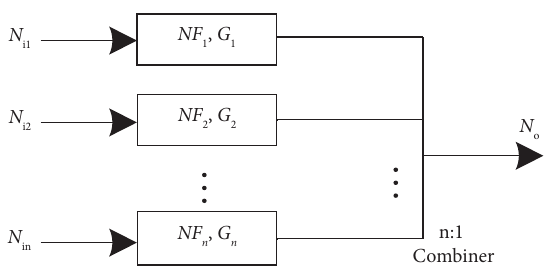
Figure 3: Noise model of a combiner